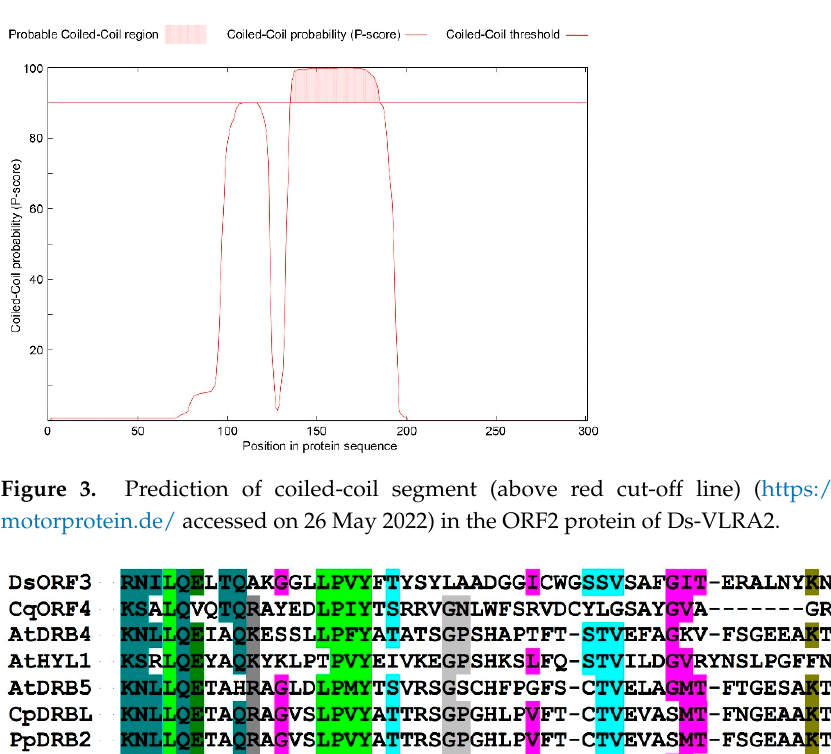
Figure 3. Prediction of coiled-coil segment (above red cut-off line) (https://waggawagga.motorpro- tein.de/ accessed on 26 May 2022) in the ORF2 protein of Ds-VLRA2.